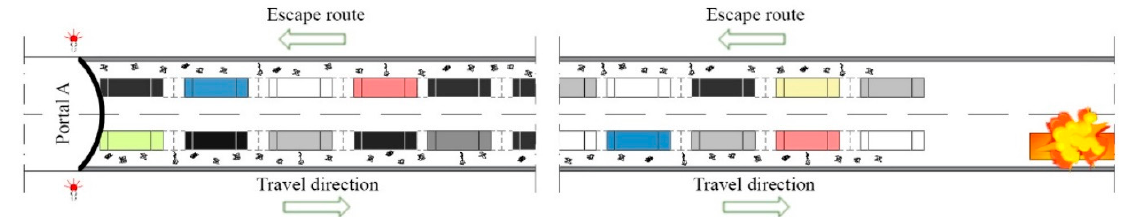
Figure 2. Schematic layout of queued vehicles upstream of the fire source.